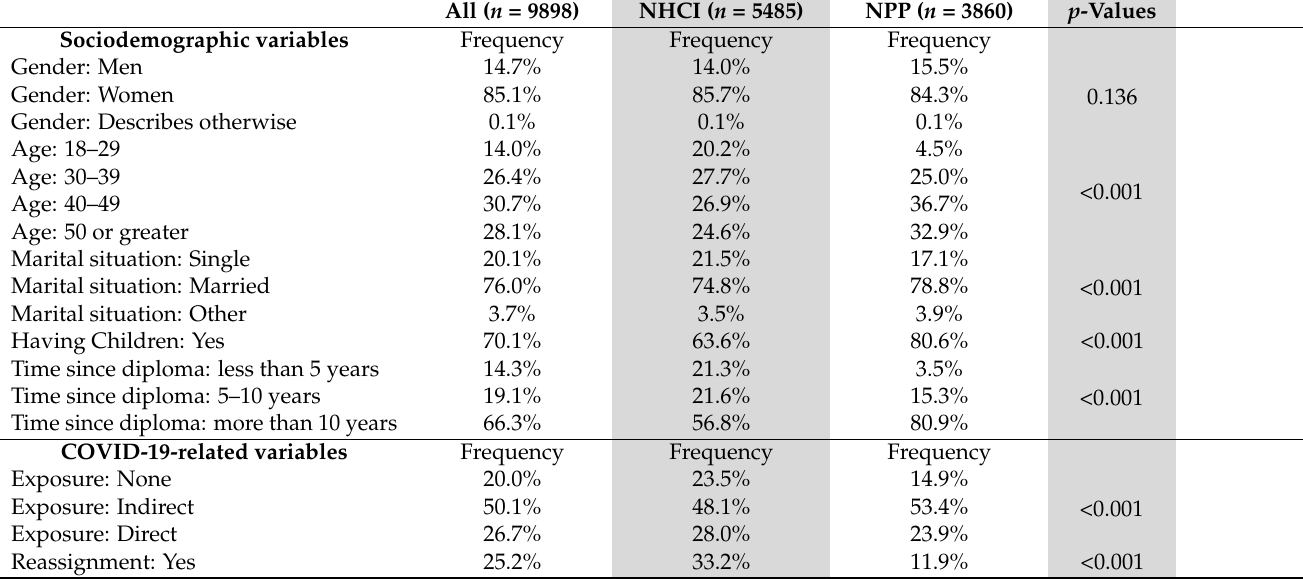
Table 1. Descriptive characteristics for the whole sample and both types of